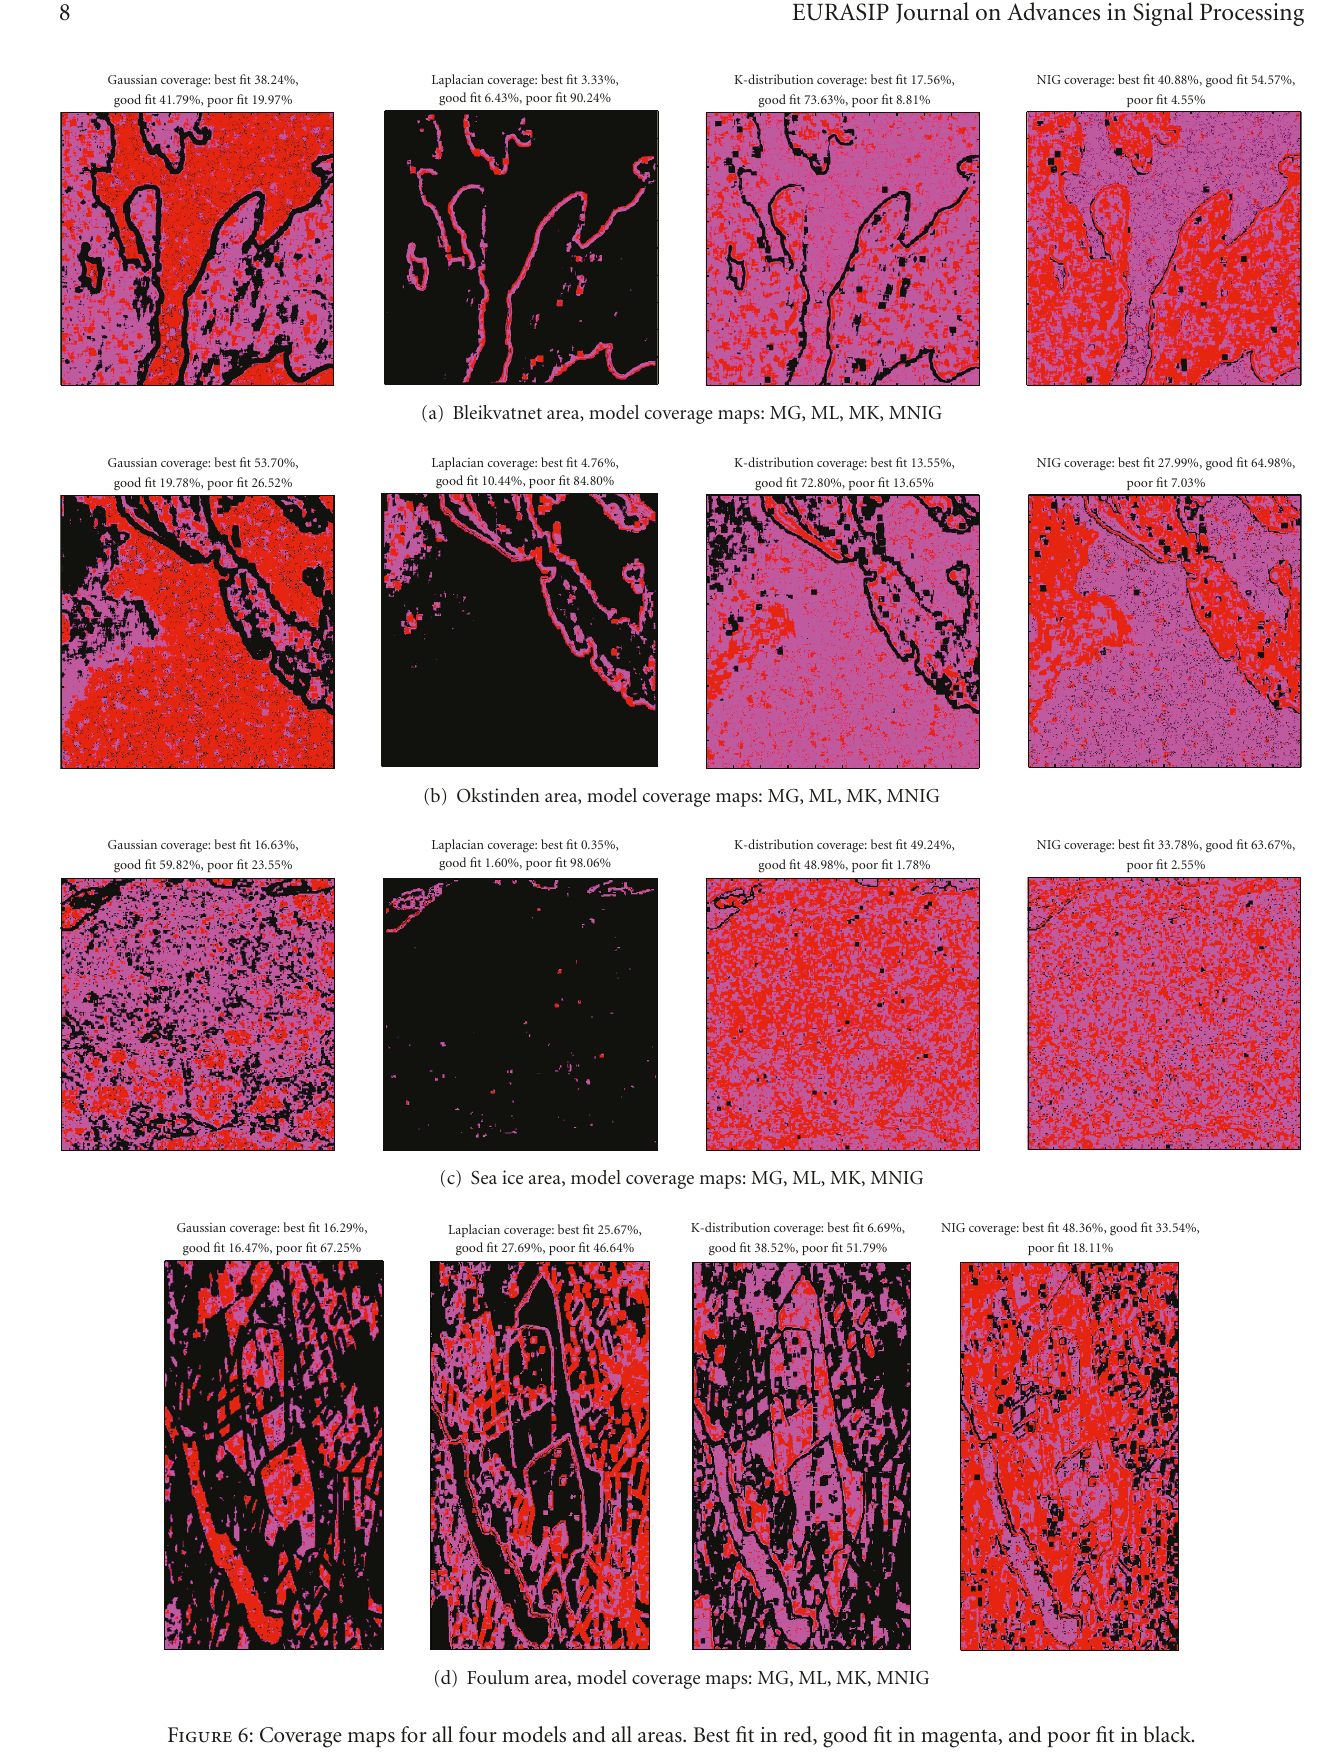
Figure 6: Coverage maps for all four models and all areas. Best fit in red, good fit in magenta, and poor fit in